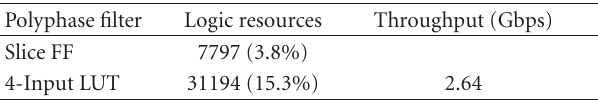
Table 5: Throughput and hardware requirement for the 2-channel, 8-tap Polyphase